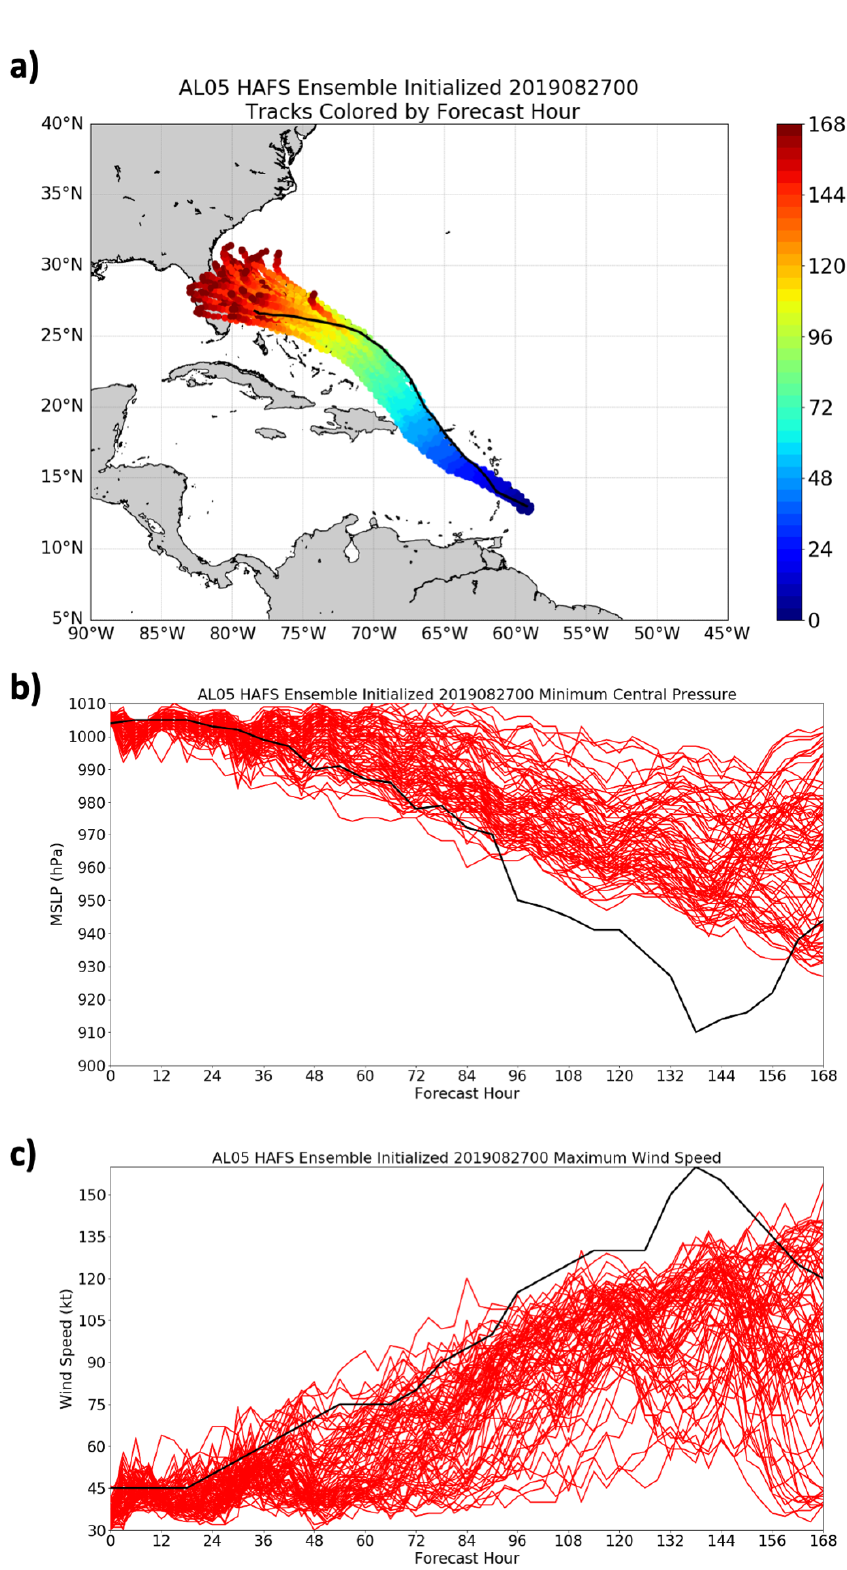
Figure 2. ( a ) Tracks of all 80 members in the HAFS ensemble initialized at 00 UTC 27 August 2019, run for 168 h. The colors are the forecast hour. The Best Track is shown in black. ( b ) Intensity (minimum pressure, hPa) of all 80 members, run for 168 h. ( c ) As in ( b ), but for maximum sustained wind speed (kt, 1 kt = 0.51 ms − 1 ). The Best Track is shown in black.